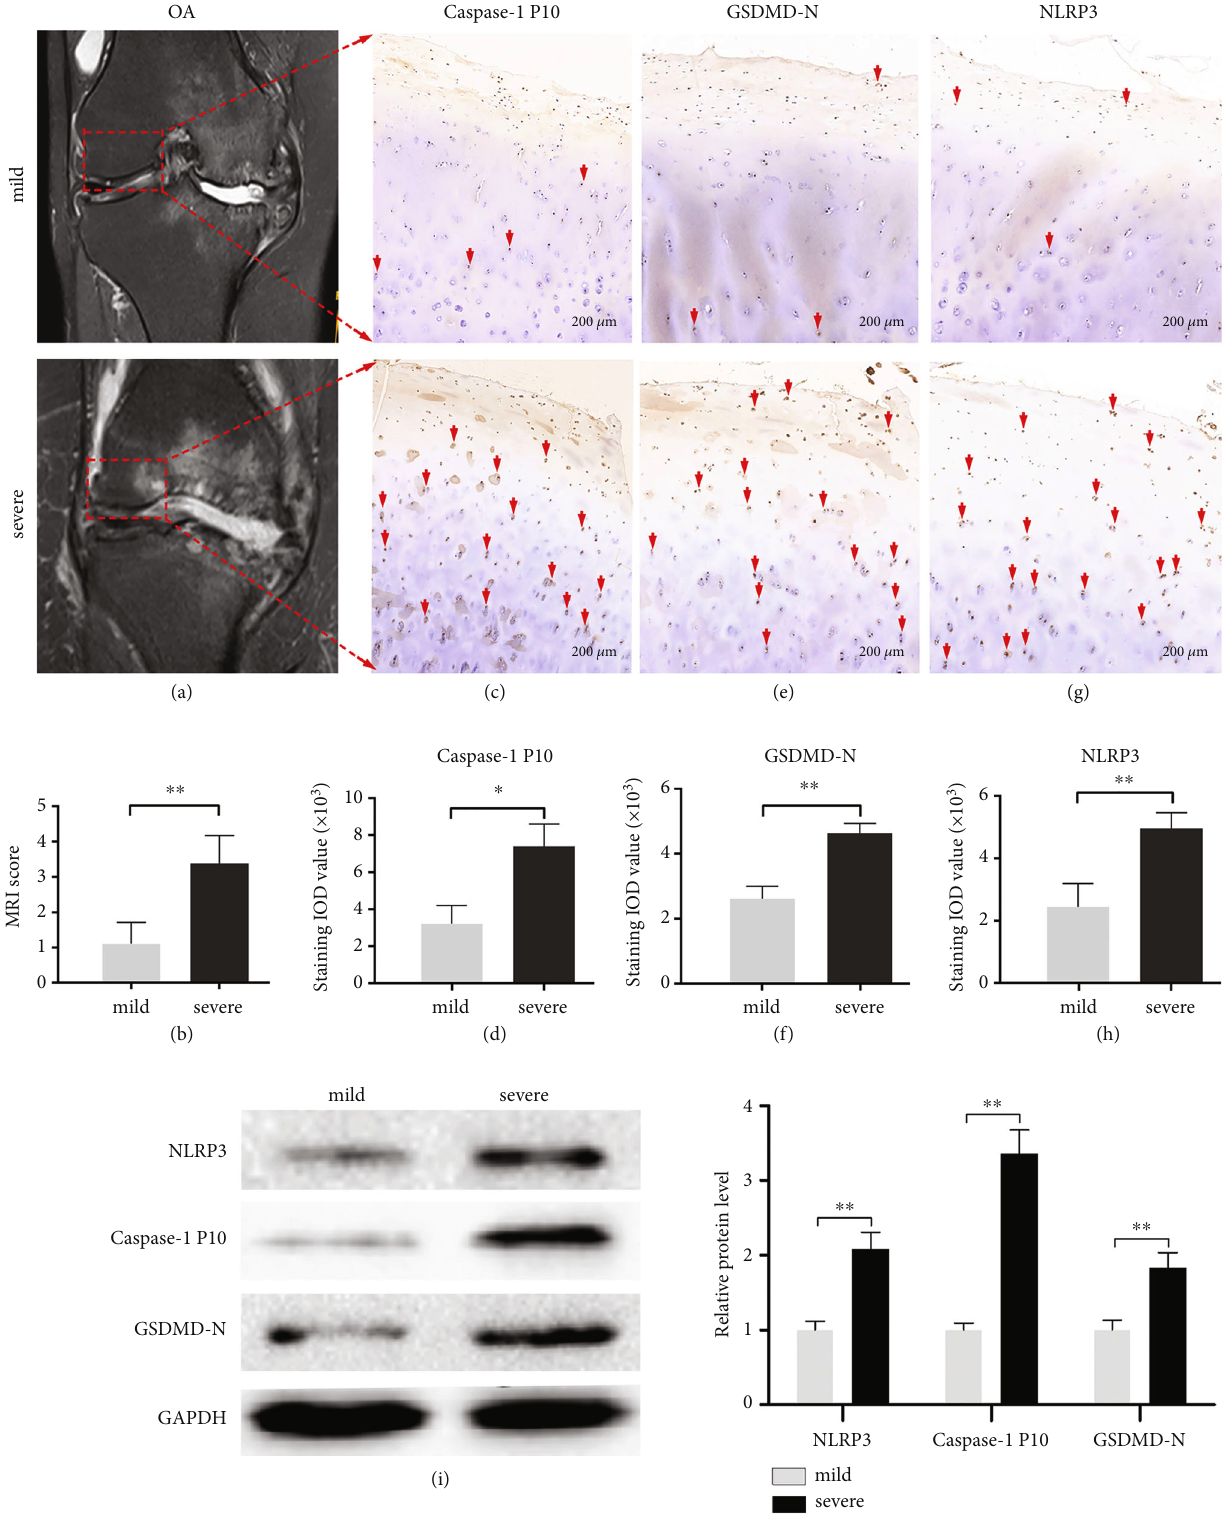
Figure 1: The upregulated levels of NLRP3, caspase-1 P10, and GSDMD-N in the cartilage of the lateral femoral condyle of the knee of a patient with severe OA. (a and b) MRI shows the lateral femoral condyle of the human knee, which has mild and severe lesions. MRI scoring was used to assess injury severity. (c – h) The levels of caspase-1 P10, GSDMD-N, and NLRP3 in mild and severe knee osteoarthritis are shown using immunohistochemical staining (bar: 200 μ m). Quanti fi cation of the immunohistochemical staining is located below. (i and j) Representative immunoblots of NLRP3, caspase-1 P10, and GSDMD-N in the mild and severe lesion groups. GAPDH was used as an internal reference. Densitometric analysis of the immunoblots is located on the right. The data represent three independent experiments. * P < 0 : 05 and ** P < 0 : 01